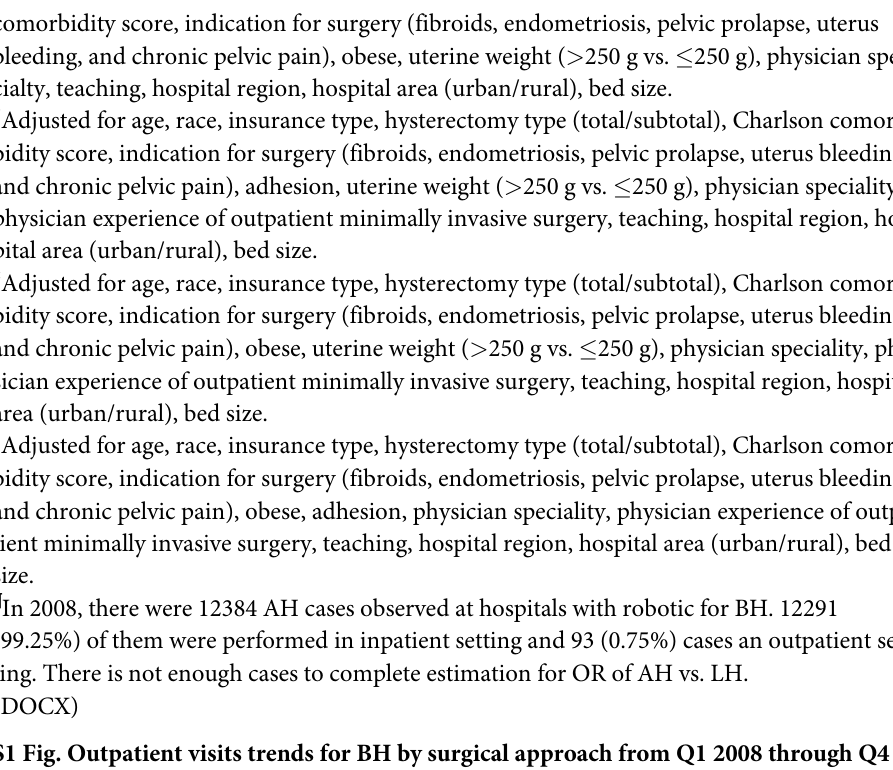
S1 Fig. Outpatient visits trends for BH by surgical approach from Q1 2008 through Q4 2014. BH, benign hysterectomy; RH, robotic hysterectomy; y, year. S2 Fig. Outpatient visits trends with complexities by surgical approach from Q1 2008 through Q4 2014. BH, benign hysterectomy; RH, robotic hysterectomy; y,